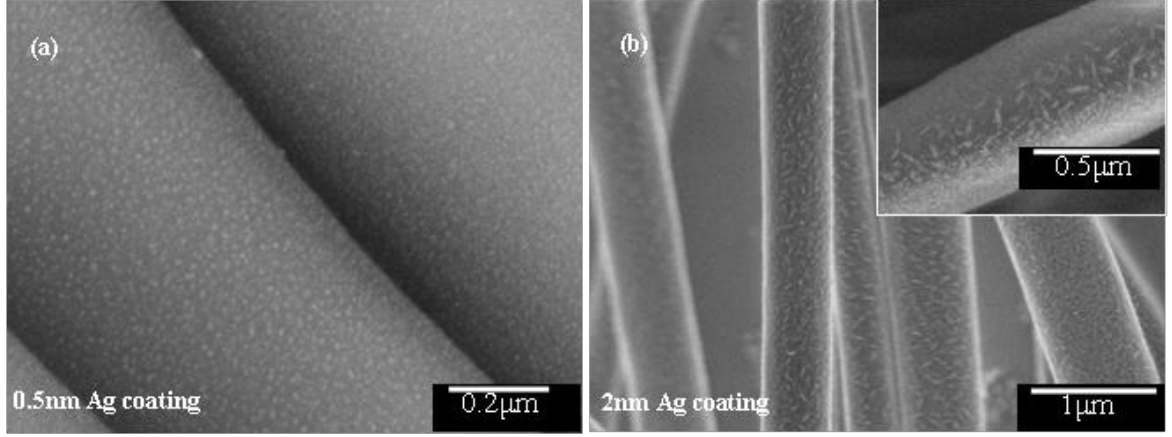
Figure 1. Variation of silver nanoparticles’ shape and size with increasing sputtering thickness (white particles on darker fibers). ( a ) 0.5 nm thick silver coating resulted in isolated round particles; ( b ) 2 nm thick coating resulted in elongated agglomerates (inset is a closer view). The micrographs were made by mixing the signal from backscattered electron and secondary electron